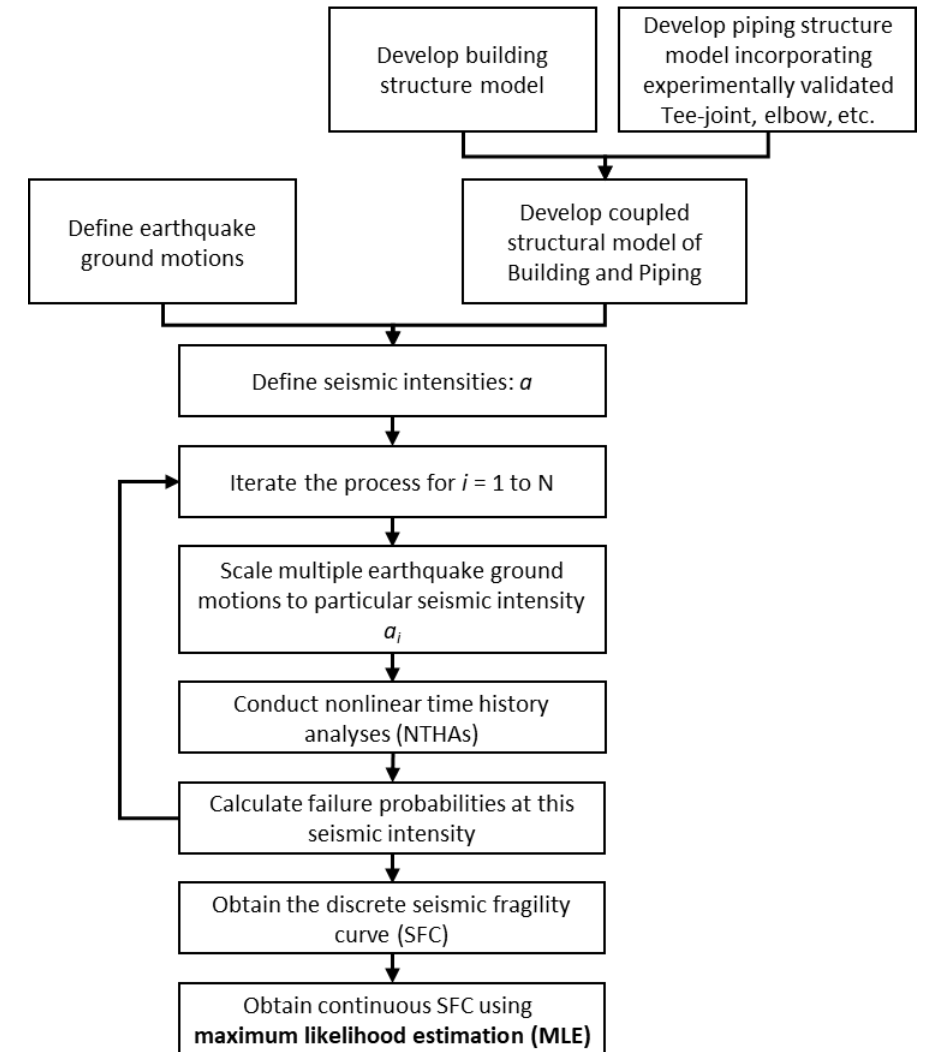
Figure 2. Process used for piping seismic fragility evaluation of incremental dynamic analysis (IDA)-based maximum likelihood estimation (MLE) method.